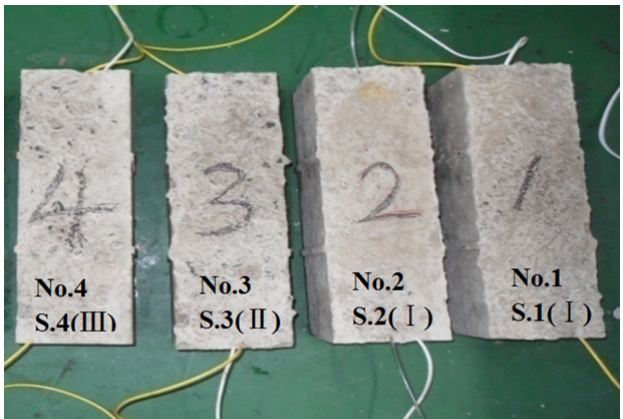
Figure 9. Concrete specimens with embedded